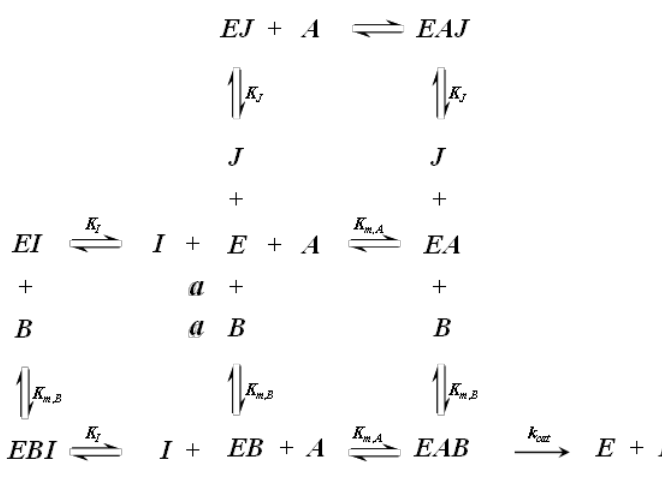
Figure A2. Random order bi-bi kinetics and competitive inhibition of species A through I and species B competing with